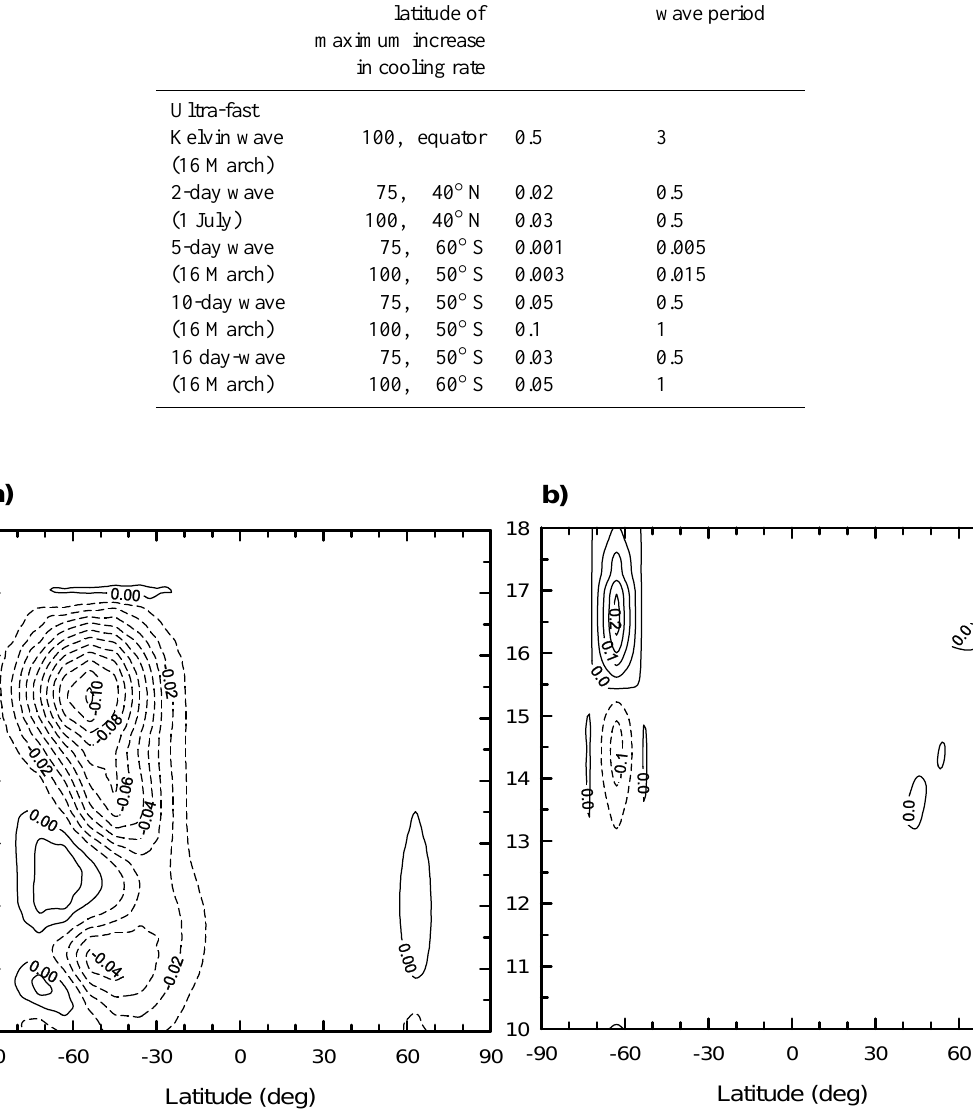
Fig. 12. As in Fig. 10, but for the 10-day